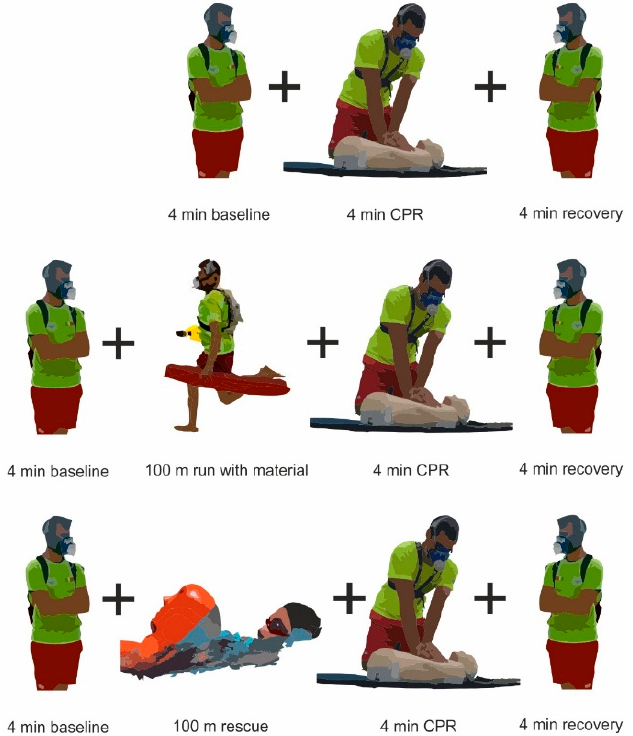
Figure 1. CPRbase, CPRrun and CPRswim experimental conditions (upper, middle and lower panels, respectively). The manikin used is in accordance with the American Heart Association and European Resuscitation Council guidelines for CPR practice [11,12].